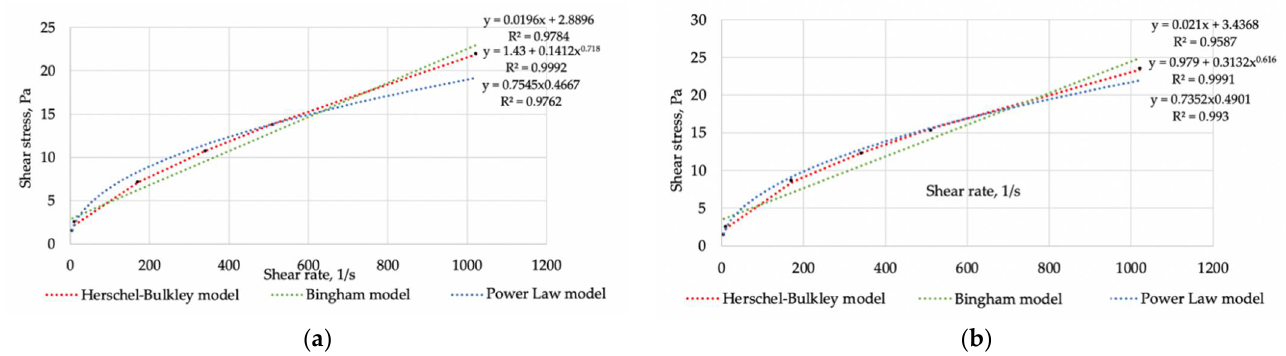
Figure 4. Selection of the rheological model for sample 2 with PHPA MM = 12 million ( a ) and for sample 3 with PHPA MM = 15 million ( b ).